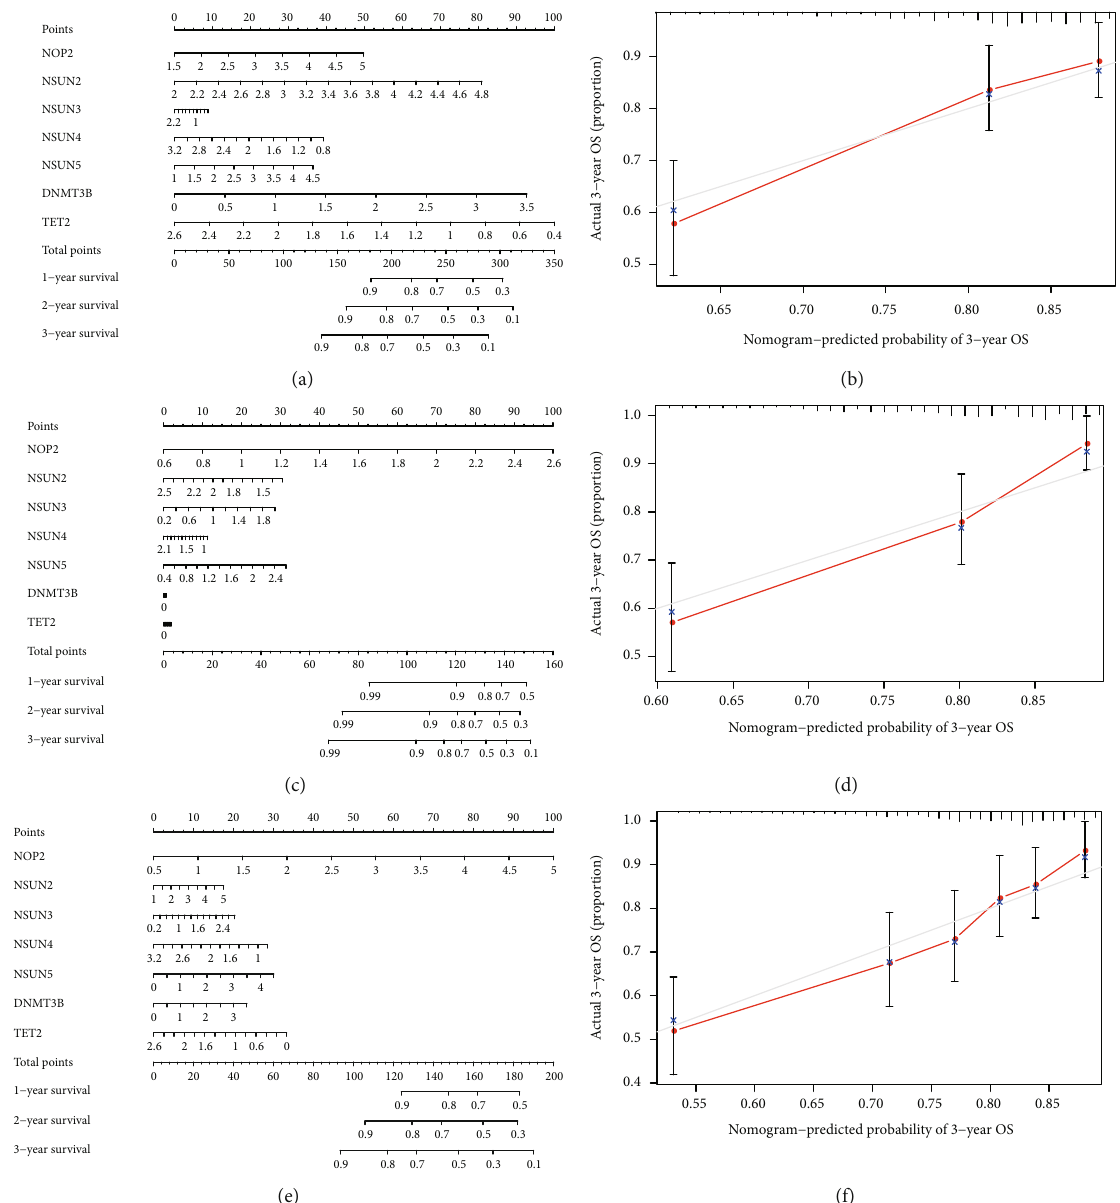
Figure 9: Nomograms to predict the survival rate of ccRCC patients in the training cohort, testing cohort, and the entire cohort. (a) The nomogram of used to predict the survival time, and (b) the calibration map used to predict the 3-year rate in the training cohort. (c) The nomogram used to predict the survival time, and (d) the calibration map used to predict the 3-year rate in the testing cohort. (e) The nomogram of used to predict the survival time, and (f) the calibration map used to predict the 3-year rate in the entire